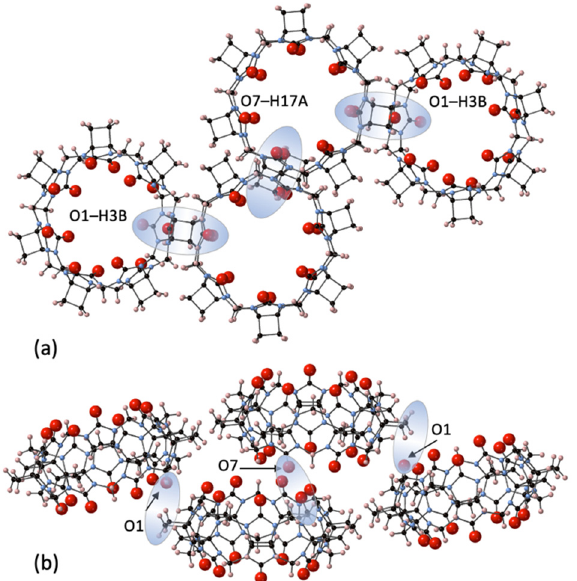
Figure 4. A segment of the crystal structure 3 showing the inter-column connections that are the predominant structural features as seen from ( a ) the portal view and ( b ) from the side view , of the CyB 7 Q[7] stacked columns, showing the dipole–dipole interactions between O1–H3B and O7–H17A (shaded highlights).